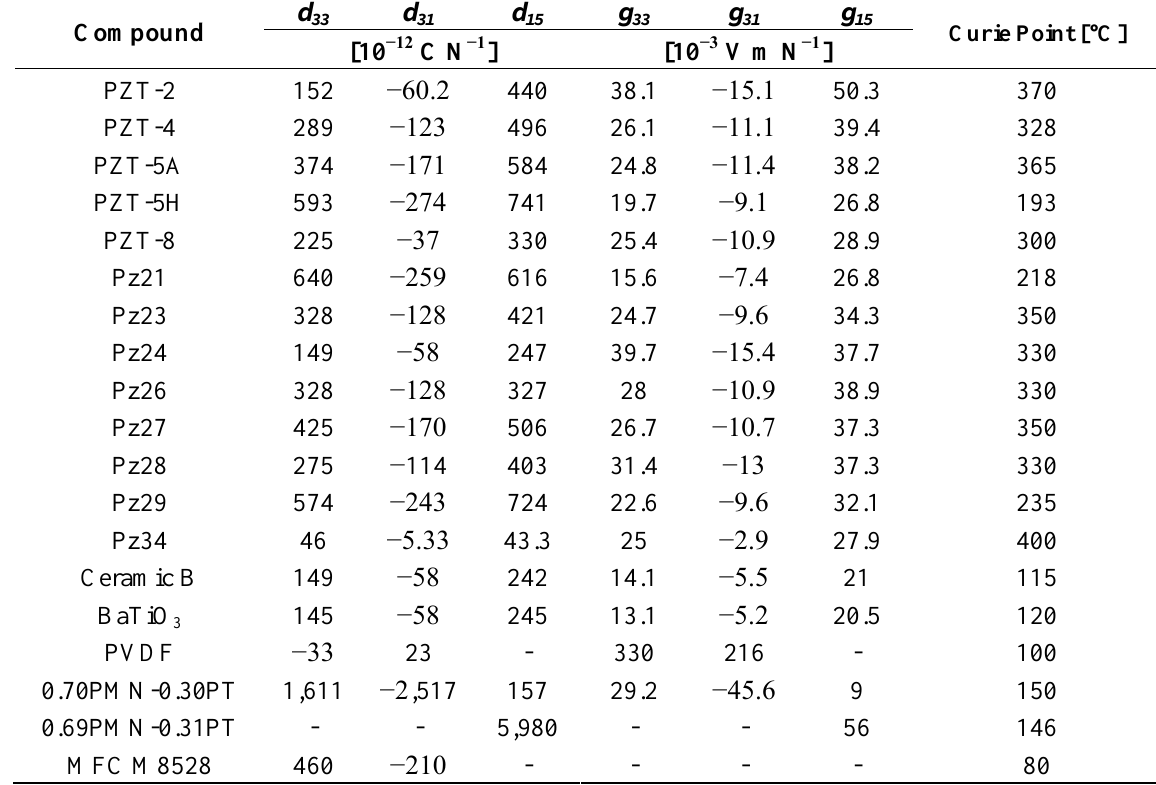
Table 1. Coefficients for common piezoelectric materials [21,37–42]. Ceramic B is a modified barium titanate with improved stability and lower aging. Last two rows report strongly different values for two PMN-PT crystals; notice that this is not due to the slightly different stoichiometric composition but to the crystallographic cut (not reported in the